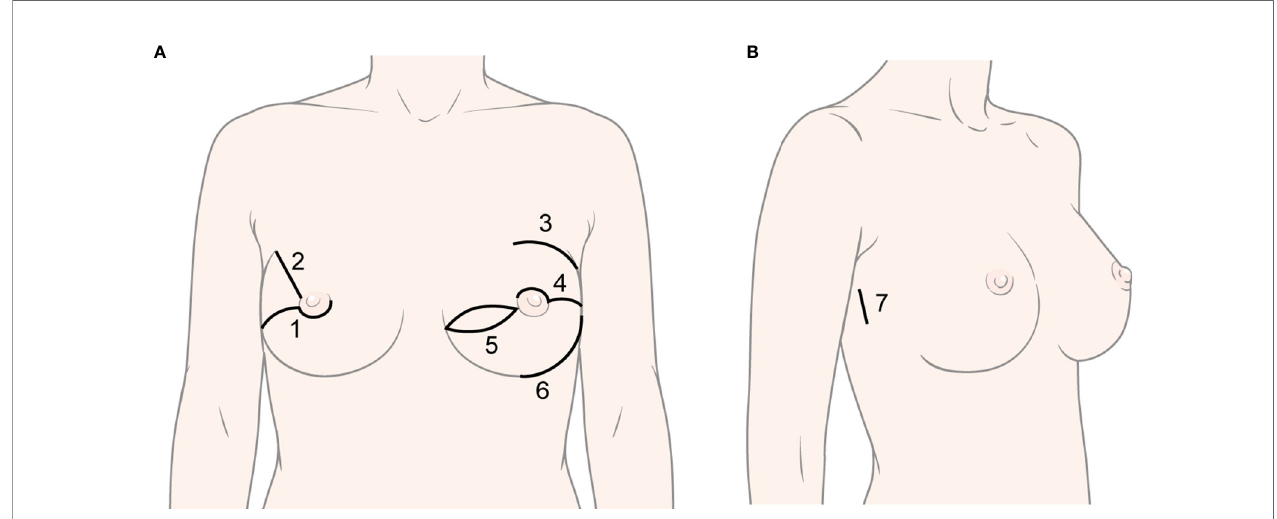
FIGURE 2 | Various types of incisions in conventional nipple-sparing mastectomy and robot-assisted nipple-sparing mastectomy. (A) Types of incision in conventional nipple-sparing mastectomy: 1) Lower-periareolar incision with/without extension, 2) Radial incision, 3) Curvilinear incision, 4) Upper-periareolar incision with/without extension, 5) Elliptical incision, 6) Inframammary fold incision; (B) Type of incision in robot-assisted nipple-sparing mastectomy: 7) Lateral